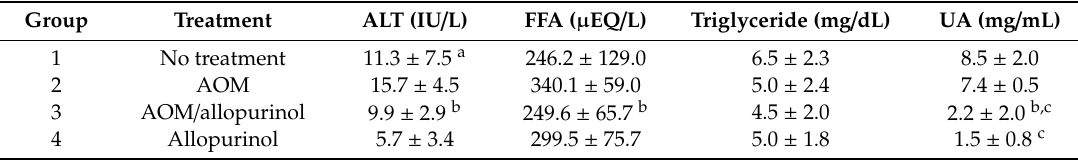
Table 2. Serum parameters of the experimental